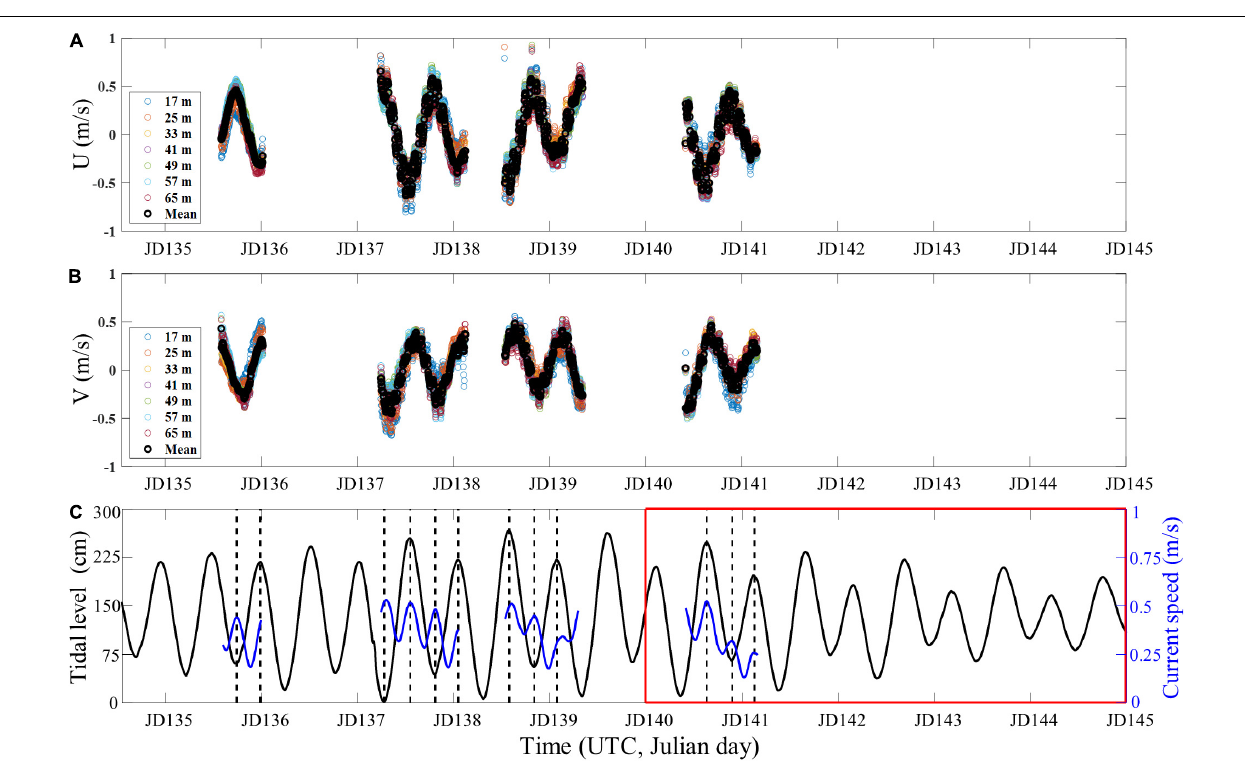
impact of the sunlight on the physical oceanic